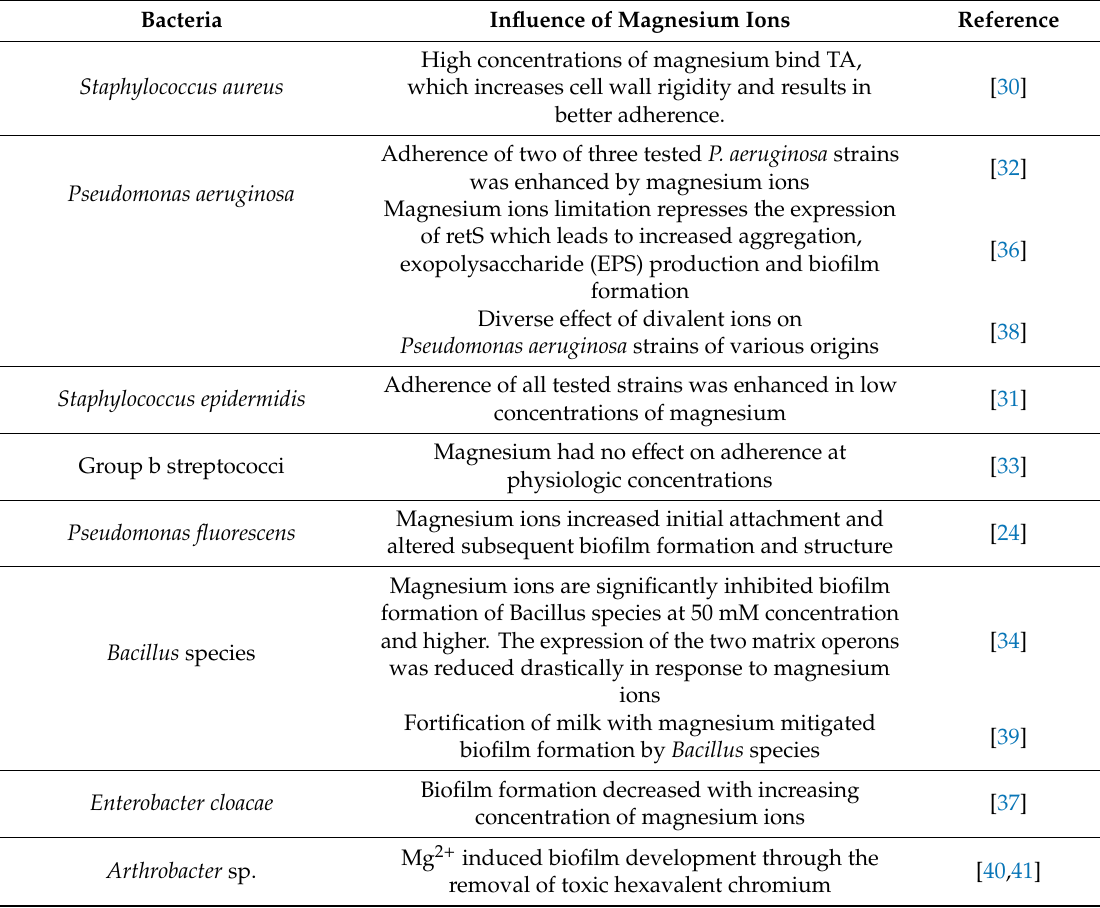
Table 1. Varying e ff ects of magnesium ions on bacterial adhesion and biofilm